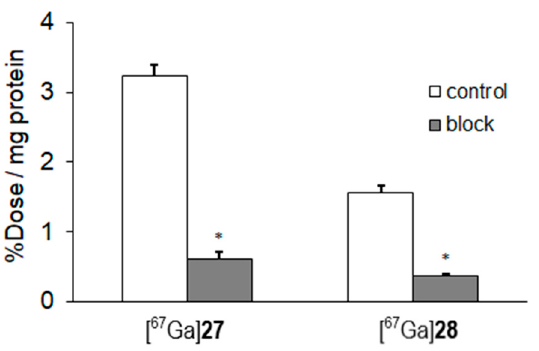
Figure 2. Uptake of [ 67 Ga] 27 and [ 67 Ga] 28 into BxPC3- luc cells at 1 h with or without IPLPPPRRPFFK as a blocking agent. Data were presented as mean ± SD for three samples. Significance was